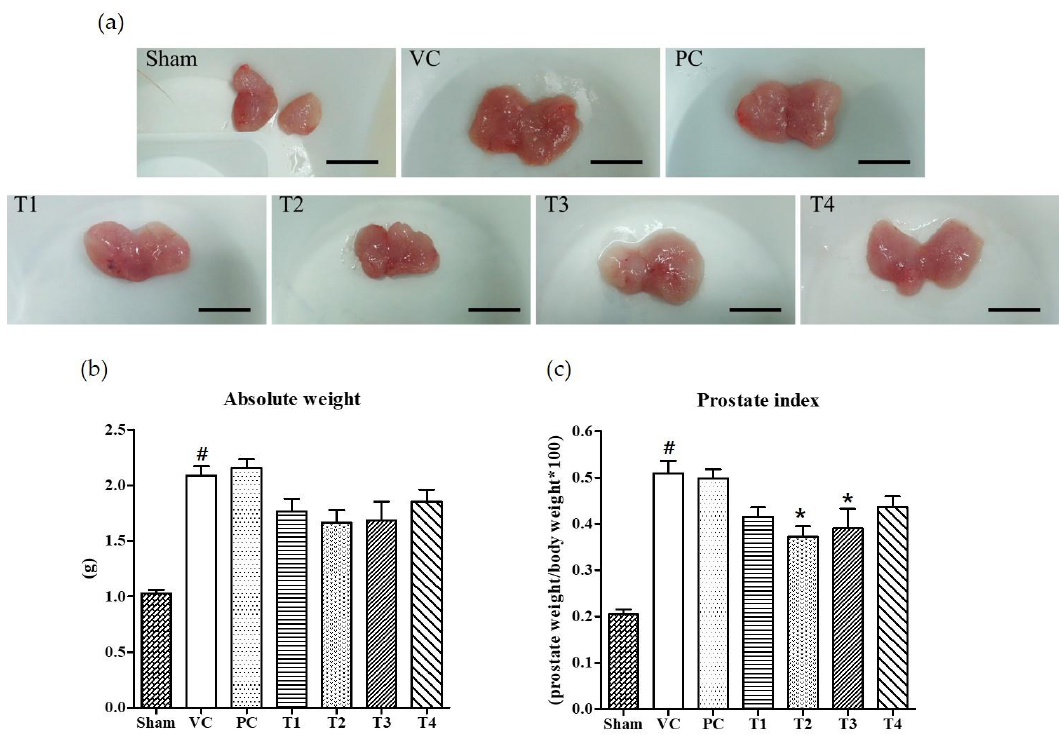
Figure 1. Effects of orally administered A. melanocarpa extracts, T1~T4 on prostate weights and prostate indices of testosterone propionate-treated Wistar rats. Clinical features of TP-induced prostate hyperplasia; Bar = 10 mm ( a ), absolute prostate weights ( b ), and prostate indices ( c ). Results were expressed as the mean value ( ± SD) of animals in each group. # p < 0.001 vs. the sham group; * p < 0.05 vs. the VC group. Sham, non-BPH-induced and received 0.5% CMC-Na; VC, BPH-induced and received 0.5% CMC-Na; PC, BPH-induced and saw palmetto-treated group. The preparation and administration of T1~T4 are described in Materials and Methods.